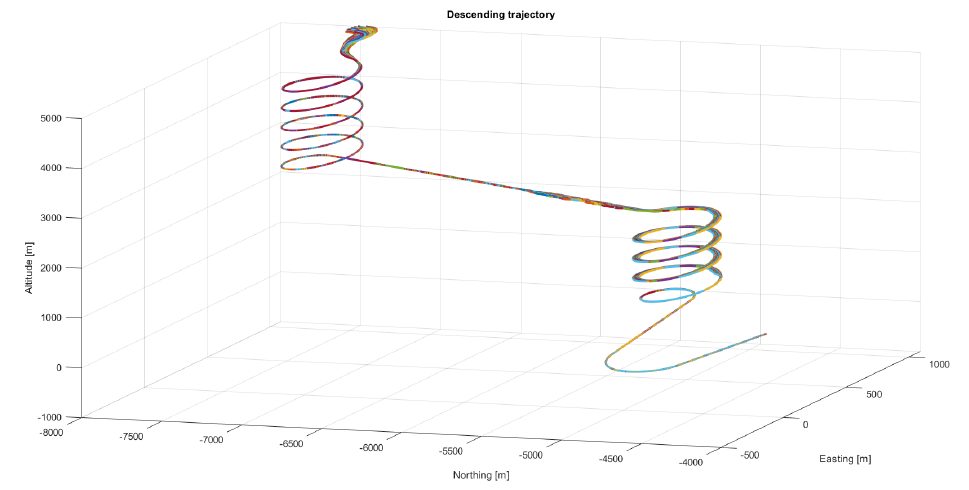
Figure 19. A set of trajectories generated changing the starting deployment point. The different colours are not relevant to the analysis in this case. They are used to distinguish the different trajectories.